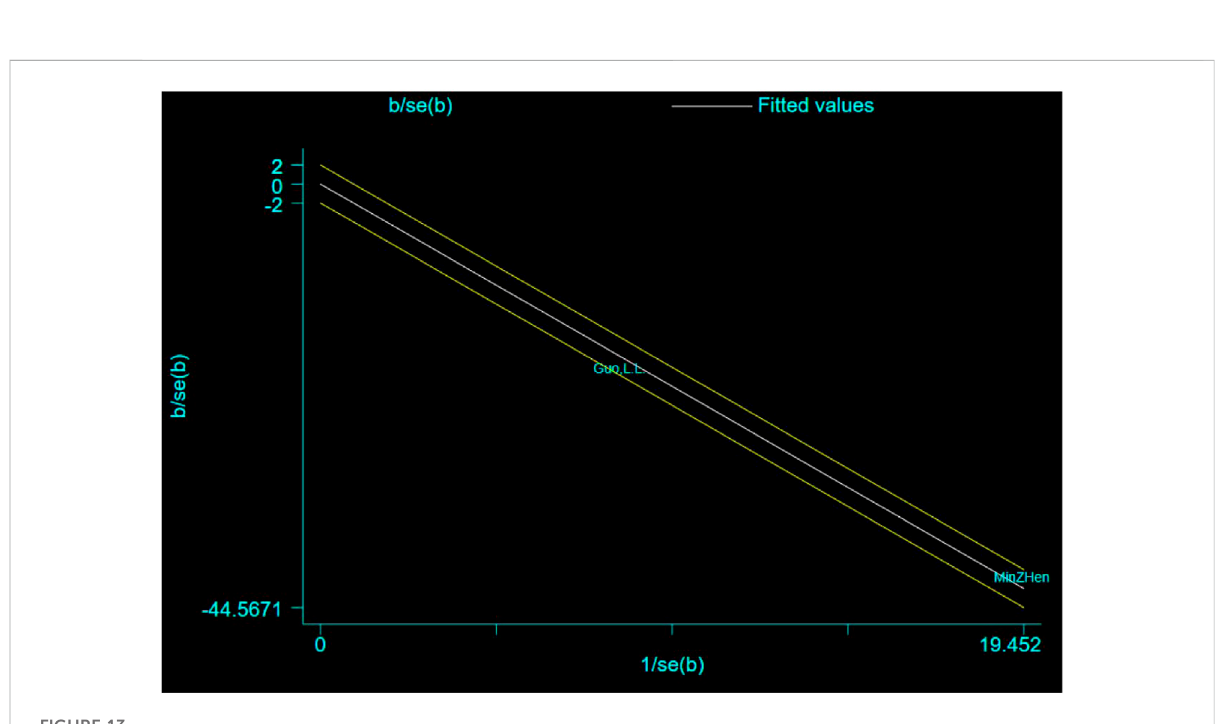
FIGURE 13 Galbraith plot for the outcome of the relative expression of amyloid precursor protein